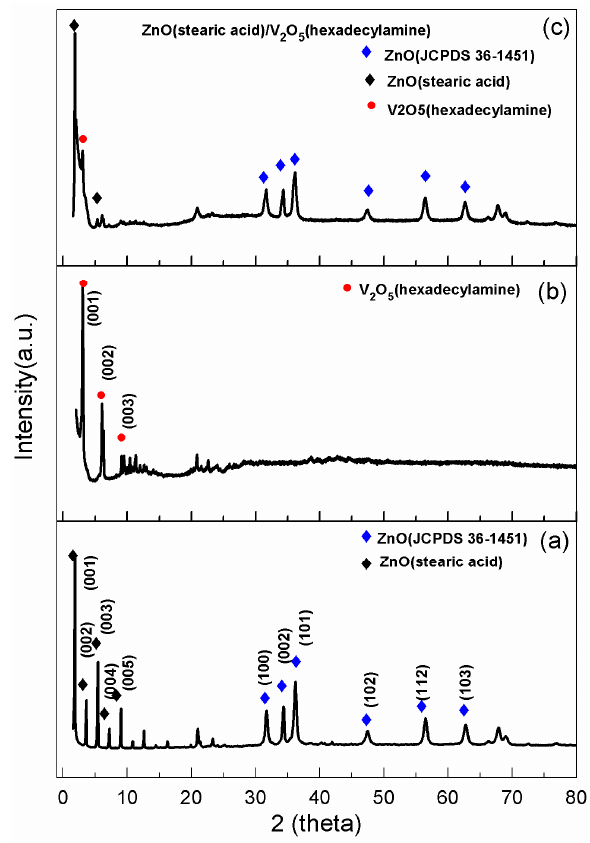
Figure 1. ( a ) XRD pattern of ZnO(SA); ( b ) XRD pattern of V 2 O 5 (HDA); and ( c ) XRD pattern of nanocomposite heterojunction ZnO(SA)/V 2 O 5 (HDA).